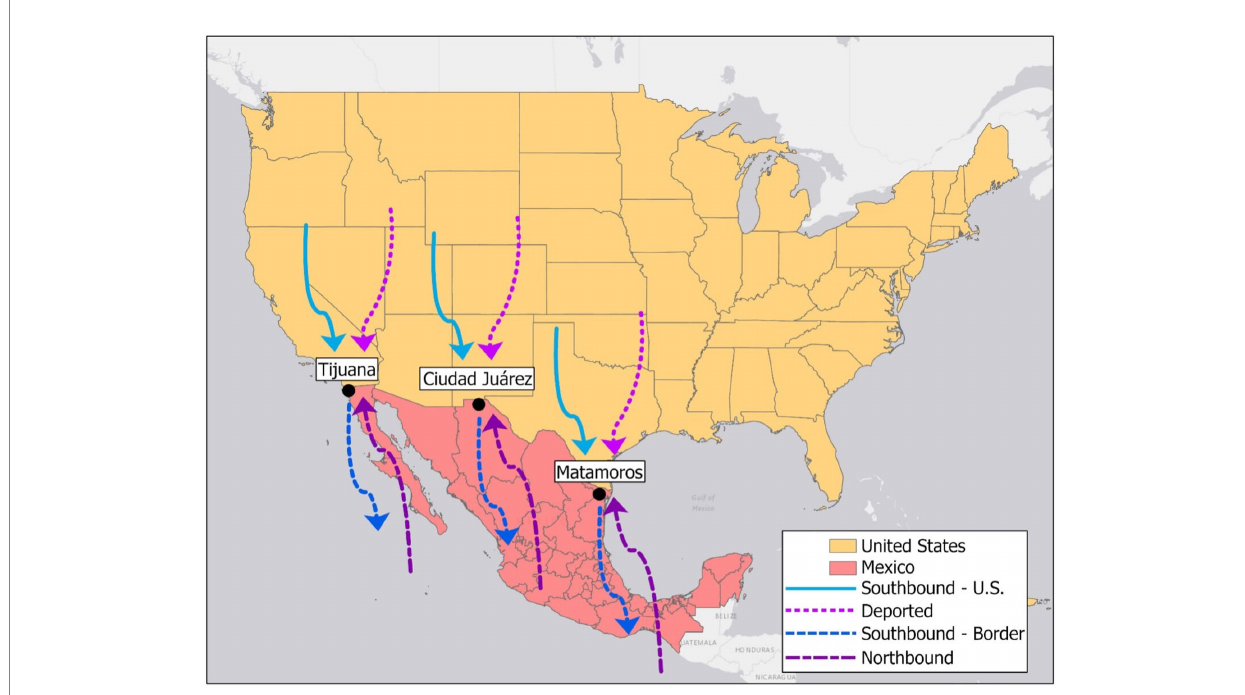
FIGURE 2 Migrant flows converging on the Mexico-U.S. border region and sampled by the Migrante